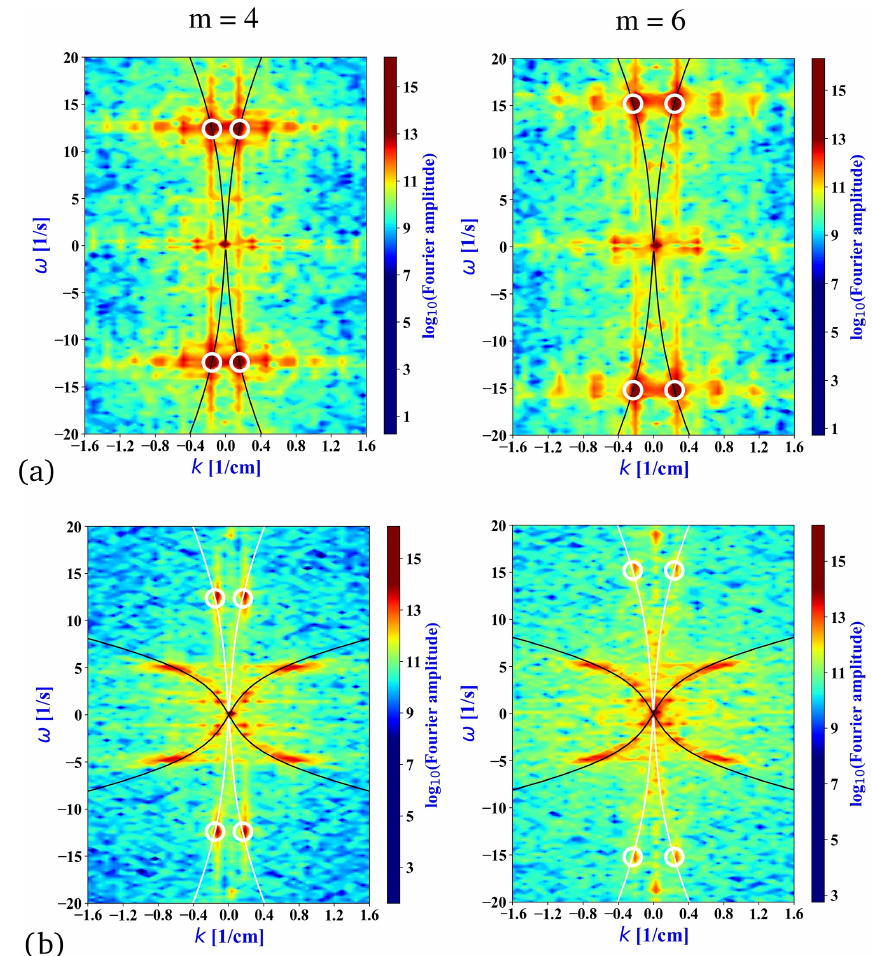
Figure 7. Two-dimensional Fourier transforms of surface displacement η(x,t) (a) and of the pycnocline displacement χ(x,t) (b) in the tank for dominant surface seiche mode m = 4 (left) and m = 6 (right) in experimental configuration #3. The white circles mark the dominant surface wave peak, whereas the black solid lines represent the respective dispersion relations Eqs. (2) and (3). √ g(cid:49)ρH 1 H 2 /(ρH) tion, which manifest in the factor c 0 =